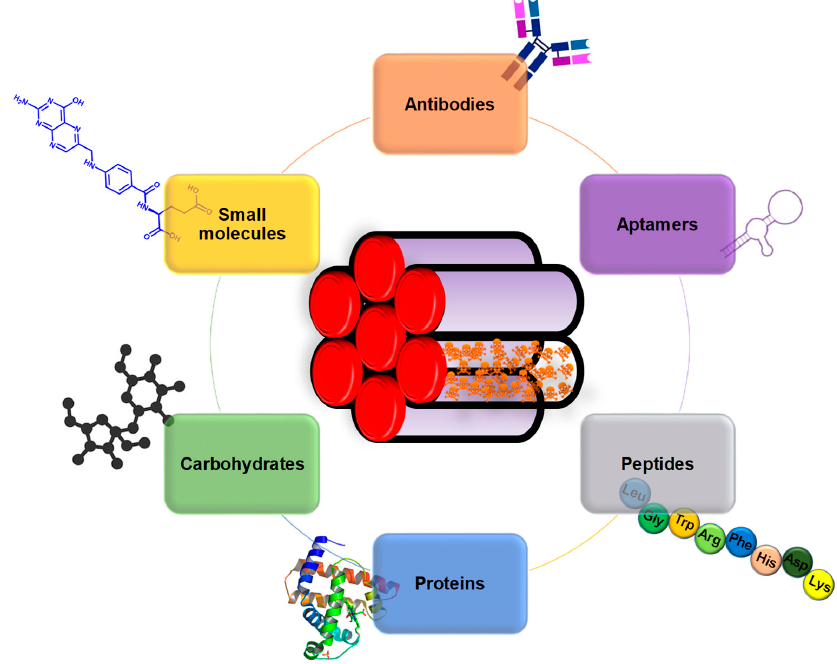
Figure 4. Schematic representation of targeting ligands employed for MSNs-based targeted drug delivery.